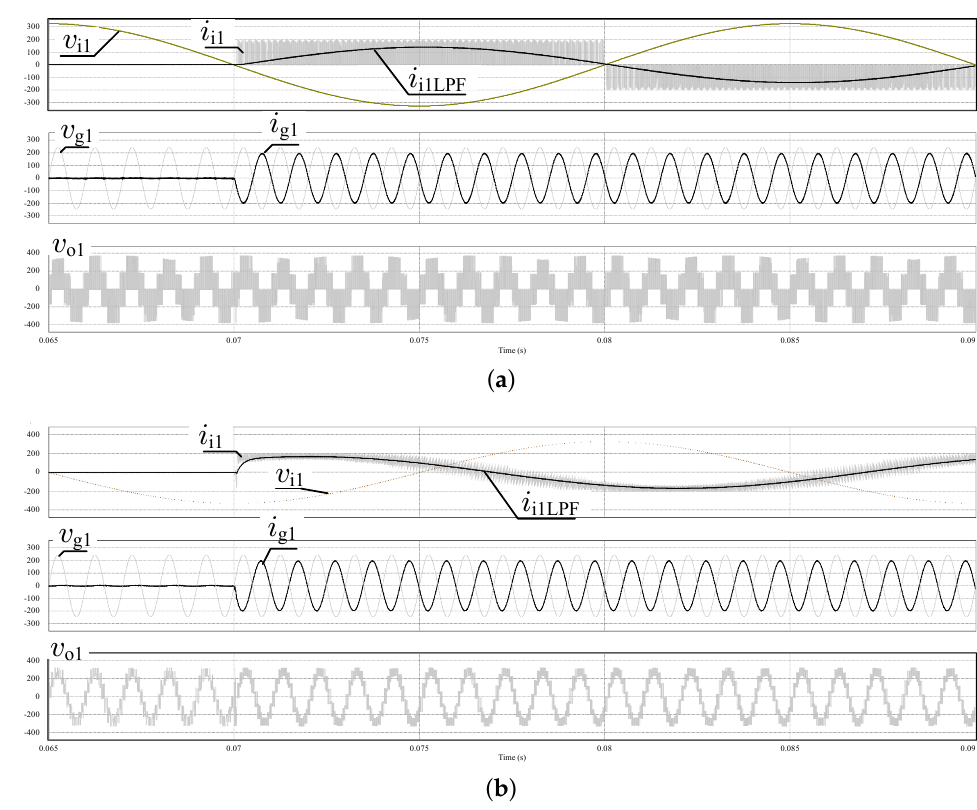
Figure 23. The step change 0–200 A of the reference active generator current in t = 0.07 s: ( a ) for CMC converter, ( b ) for MMCCR converter.